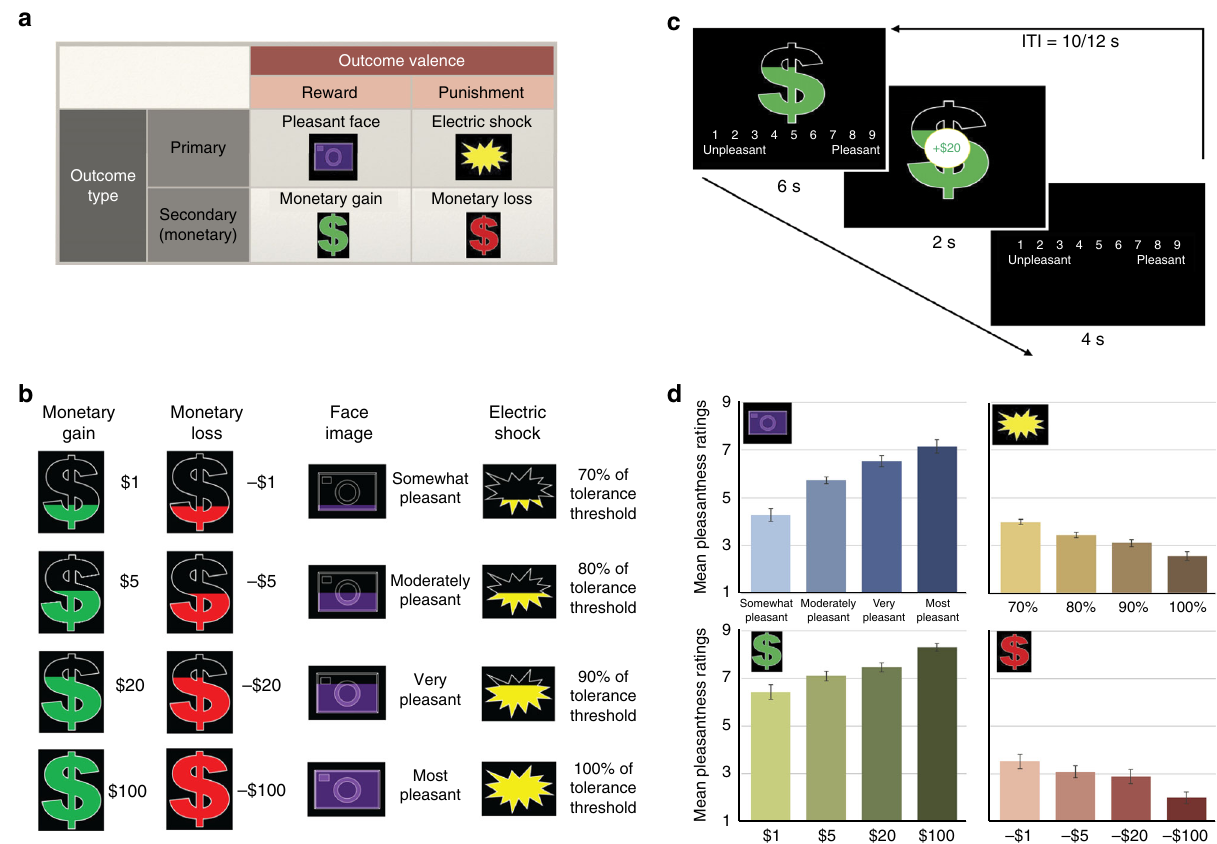
Fig. 1 Multi-category valuation paradigm and behavioral pleasantness ratings. a Four outcome categories were included in the paradigm. These categories, resulting from the crossing between outcome valence (reward/punishment) and outcome type (primary/secondary), were: viewing pleasant faces, receiving electric shocks on one ’ s ankle, monetary gains, and monetary losses. Each of these outcome categories was represented by a distinct shape, which the participants learned beforehand. These shapes served as cues that predicted the potential upcoming outcome in the current trial. b Four levels/ intensities were included within each outcome category. Participants only received the predicted outcome in 1/3 of the trials; in the remaining trials nothing was delivered. In those actualized trials, participants could receive one of four different levels/intensities of the predicted outcome, which was indicated by the levels to which the corresponding shapes were fi lled. For instance, in monetary gains, the amount of money delivered could be $1, $5, $20, or $100. For other outcome categories see the Methods section. c Trial timeline. Each trial began with a cue presentation. Participants had to provide their pleasantness rating for the cue within 5.5 s. Two buttons on a botton box moved a cursor to the left and to the right along the 1 – 9 scale, and a third button was used to register the selection. A brief delay period of 0.5 s and a presentation of the outcome for 2 s then followed. For actualized shock trials, a 2 ms electric shock of the speci fi ed level was delivered during this time. For non-actualized trials of all categories, the message “ No Outcome ” appeared on the screen. Participants then had another 4 s to rate the outcome pleasantness. The trial length was held constant at 12 s, and the inter-trial interval was jittered between 10 s and 12 s. d Pleasantness ratings for cues predicting outcomes of different levels and of different categories (average across 18 participants, error bars denote SEM). A statistically signi fi cant two-way interaction between valence and magnitude indicated opposing trends of pleasantness ratings as a function of magnitude in reward and punishment categories. See Supplementary Fig. 2 for the pleasantness ratings for delivered and